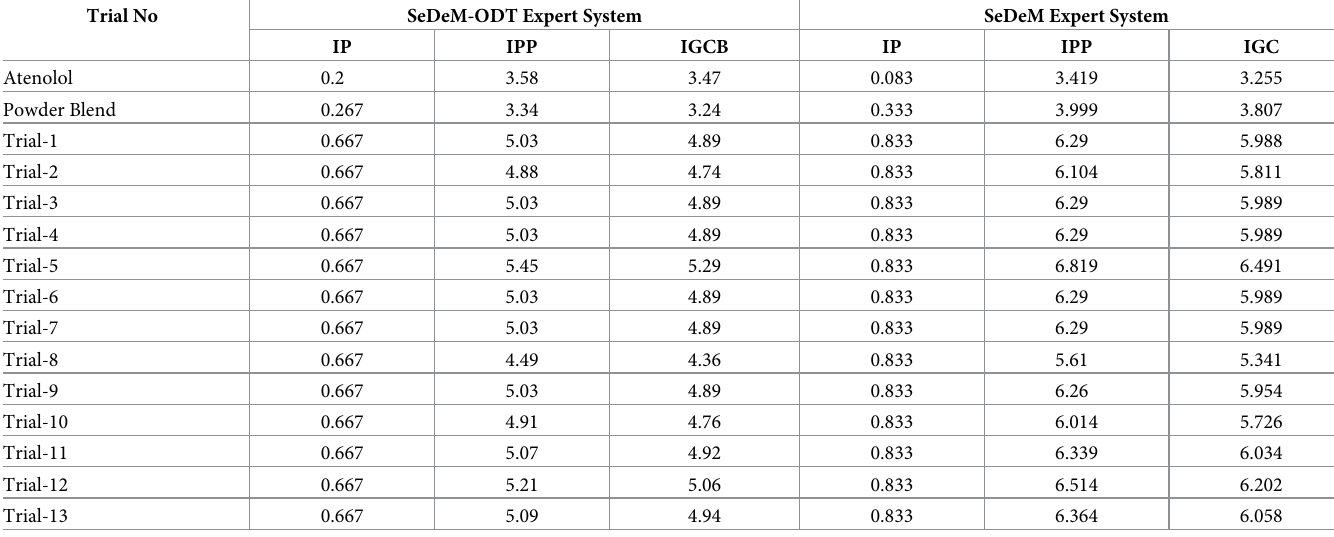
Table 7. Values of different indices calculated on the basis of SeDeM and SeDeM-ODT experts system.